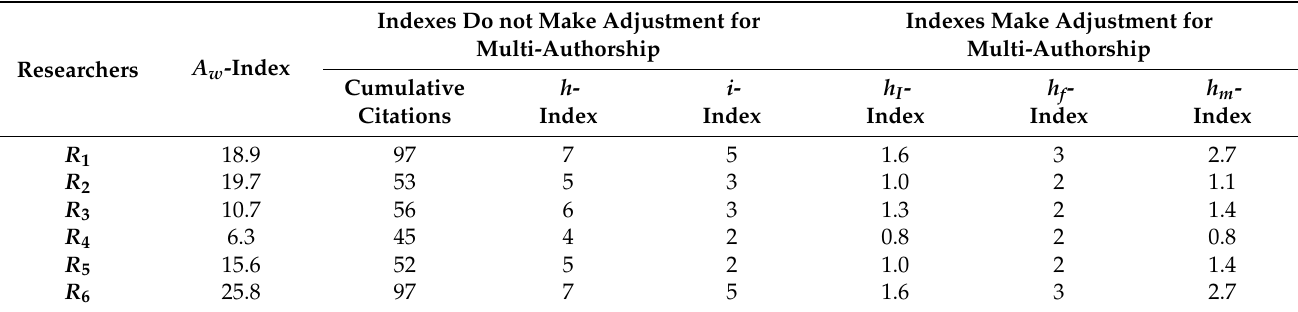
Table 3. Comparison of A w -index with major bibliometric